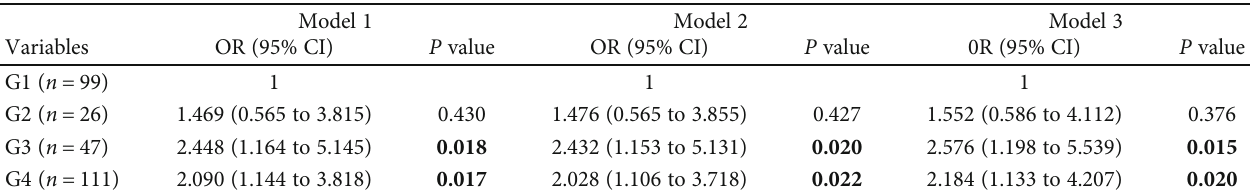
Table 5: The association of di ff erent TG control groups with the most reduced